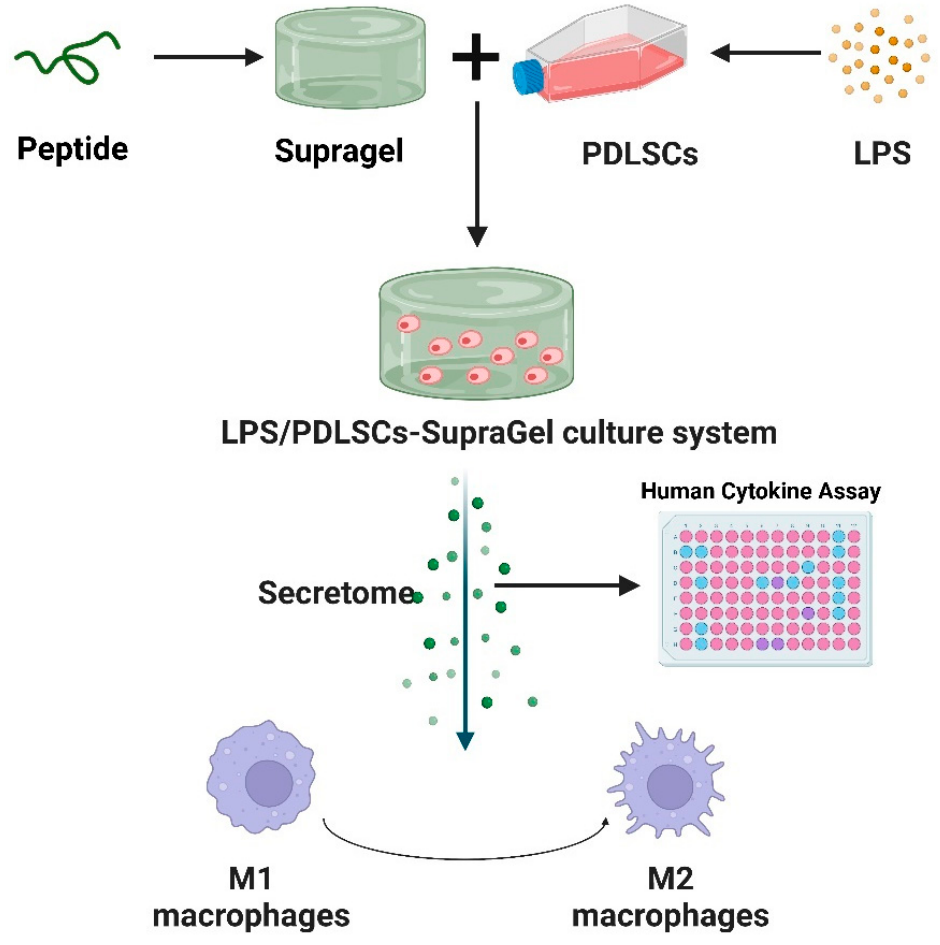
Figure 1. Schematic diagram of 3D-cultured LPS-pretreated PDLSC-derived secretome on macrophage polarization; created with BioRender.com (accessed on 27 March 2023).